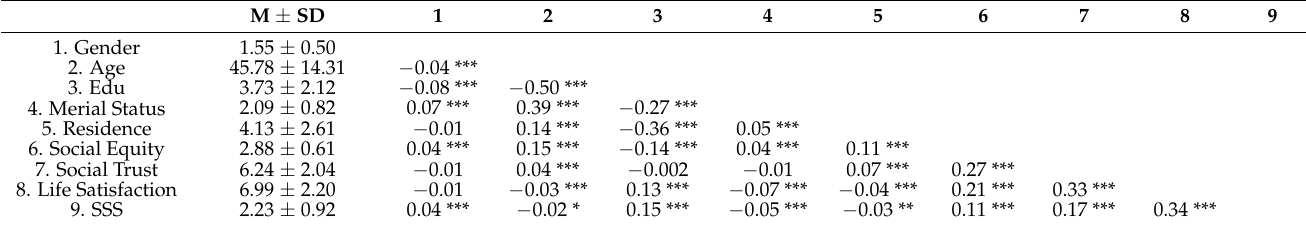
Table 1. Descriptive statistics and related analysis results for each variable.